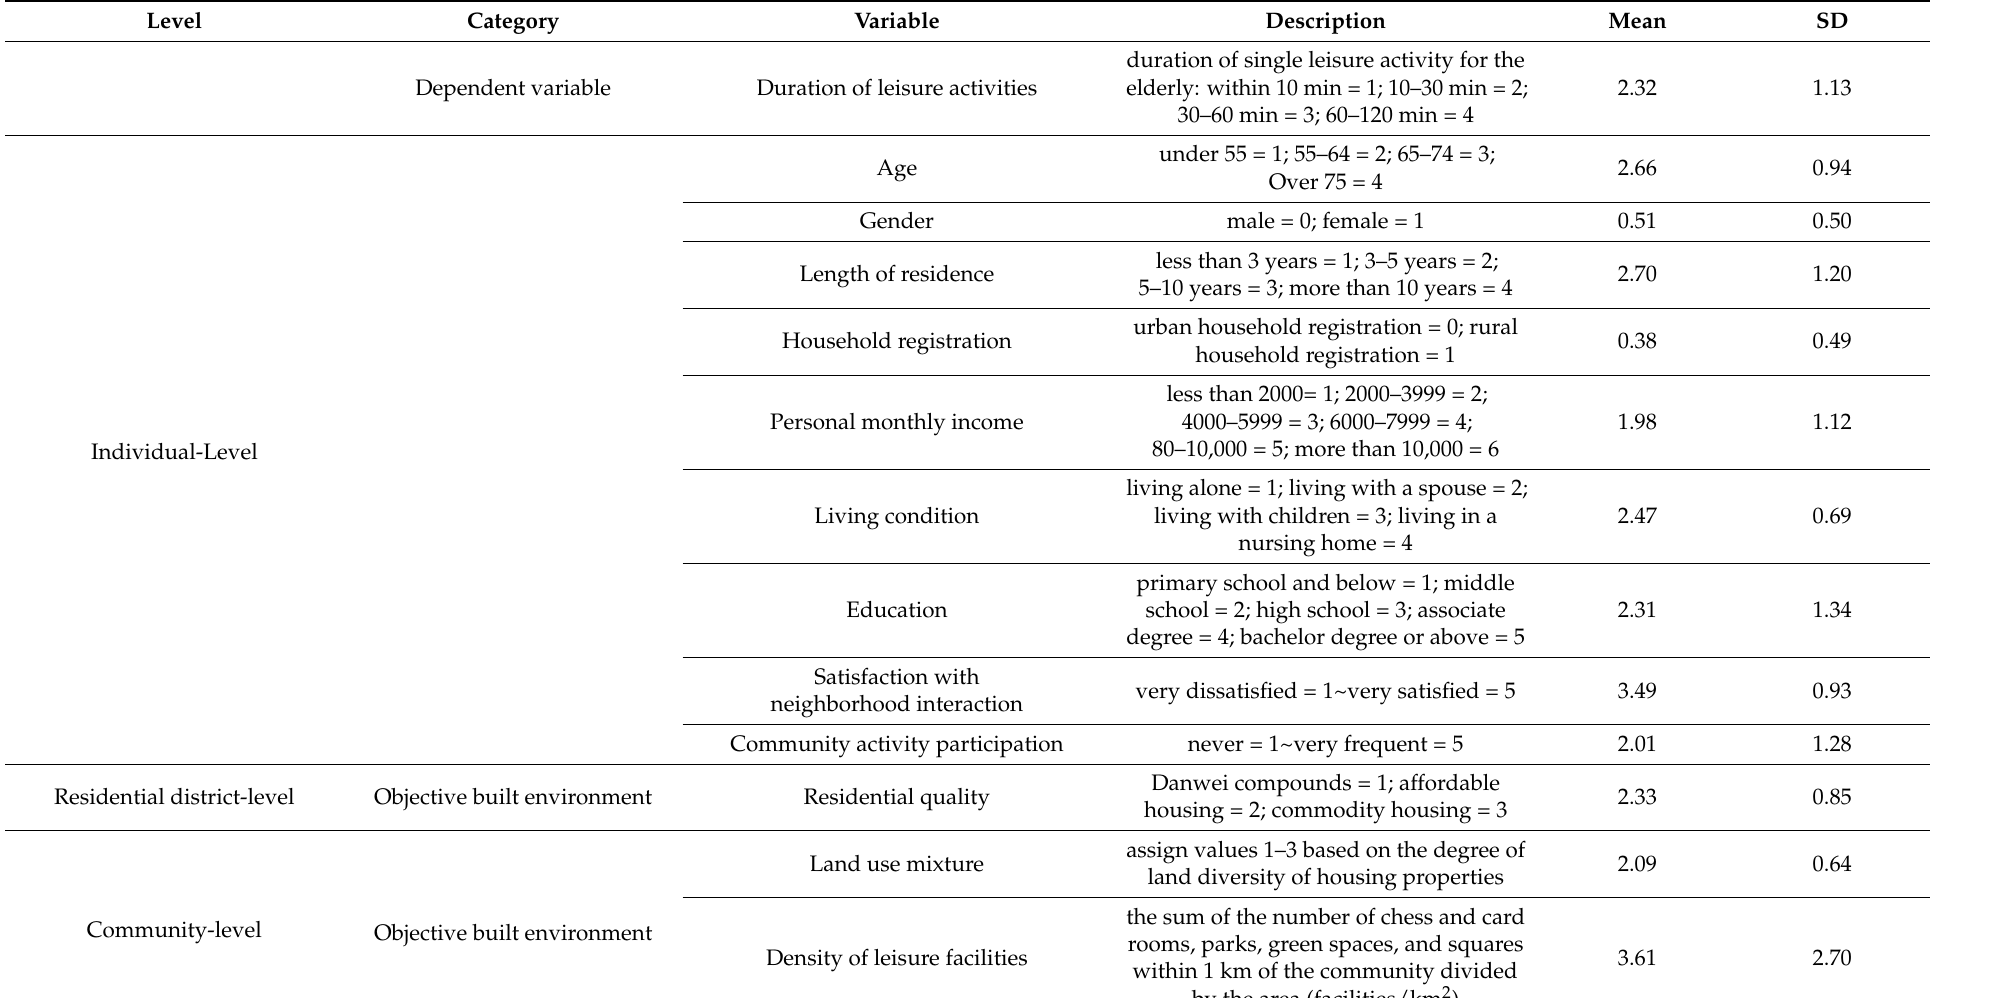
Table 3. Variables definition and descriptive